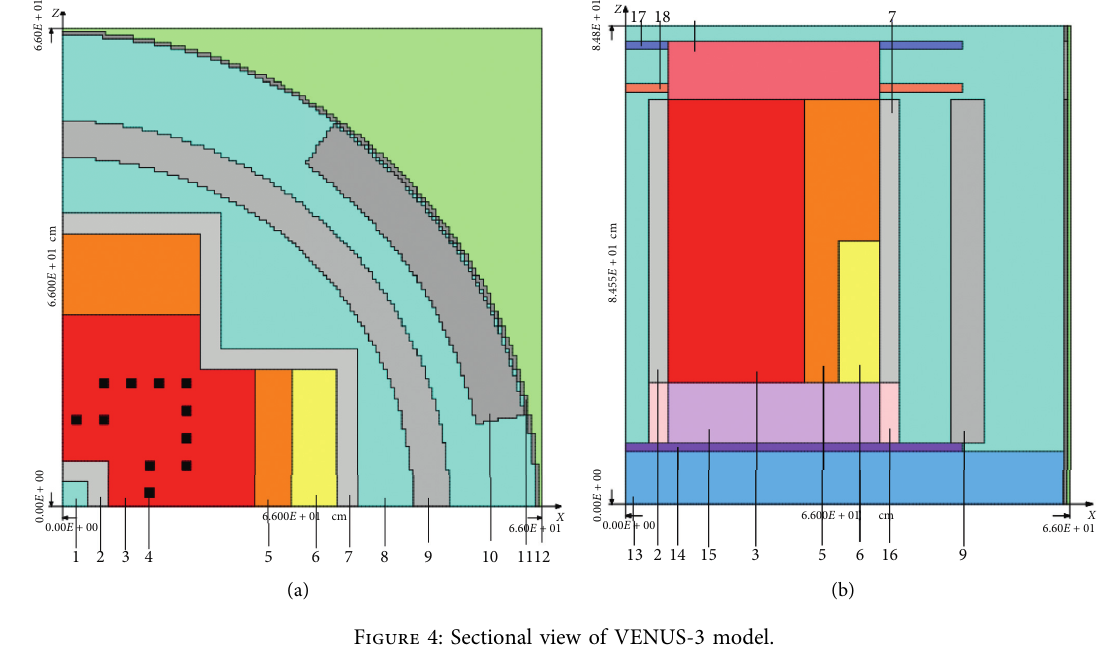
Figure 4: Sectional view of VENUS-3